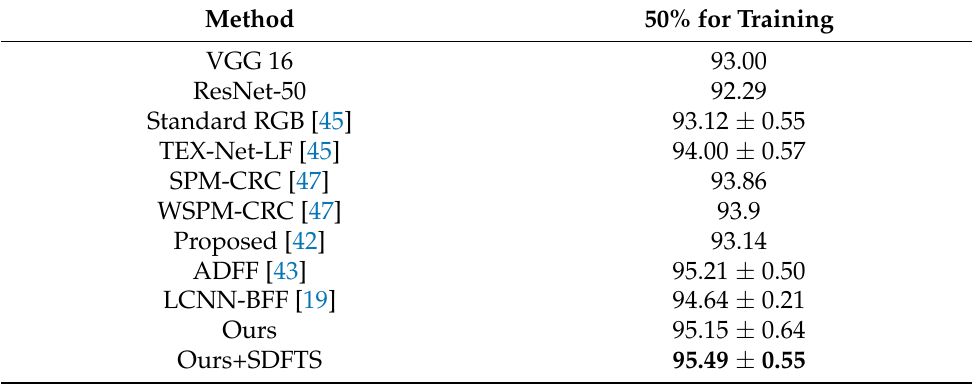
Table 6. The performance comparison on the RSSCN 7 dataset. SDFTS represents the stochastic decision-level fusion training strategy. The bold values denote the best performance of different training